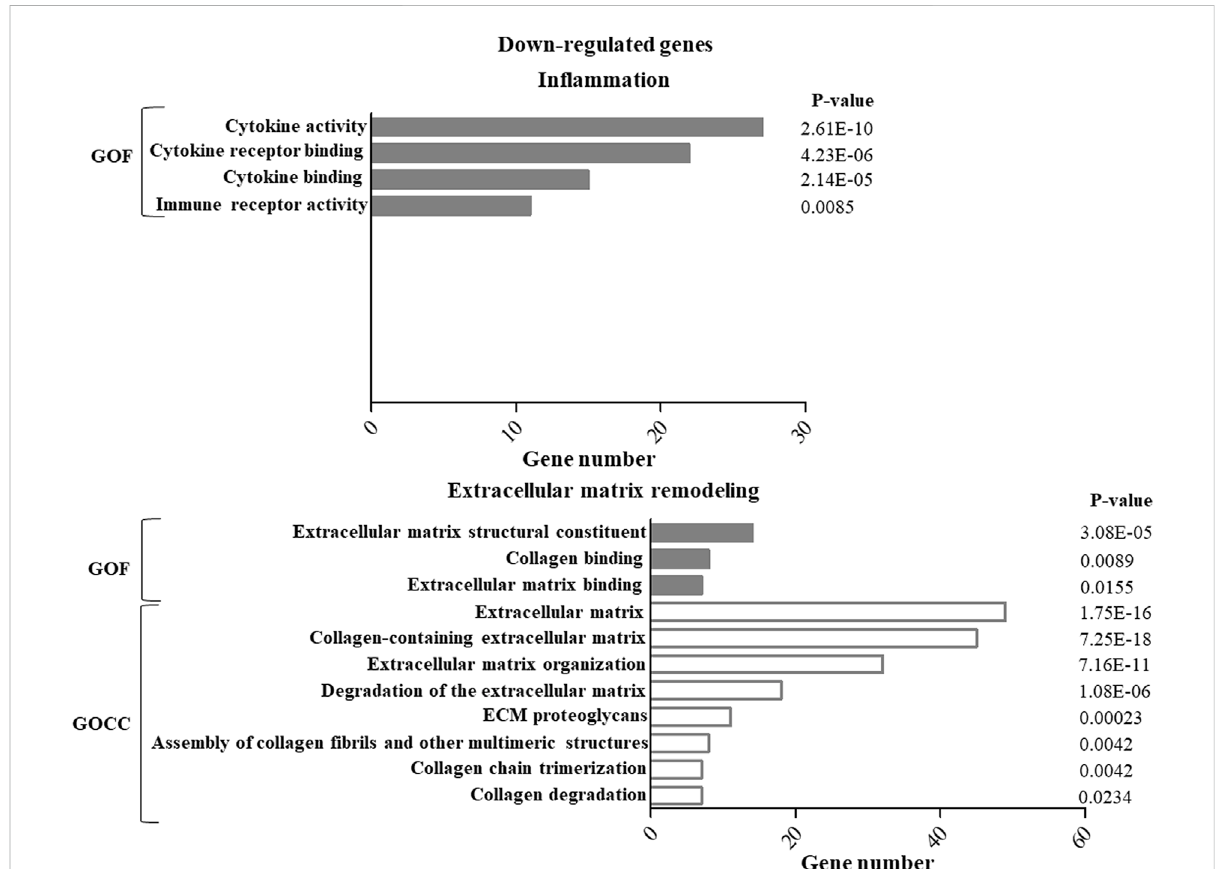
FIGURE 2 GO enrichment analysis of down-regulated genes in ASCs after IL-1 β priming. Down-regulated genes were analyzed using the GO function (GOF)andcellularcomponent(GOCC)collections.AGOtermwassigni fi cantlyenrichedif p -value ≤ 0.05andFDR ≤ 0.05.Genescouldbecomprised in more than one term depending on the function of the encoded protein. The graph shows the most relevant GO terms. The GO term name is reported on the y -axis; the number of enriched genes for each term is indicated on the x -axis. GO terms are listed by decreasing number of genes. The p value for each GO term is